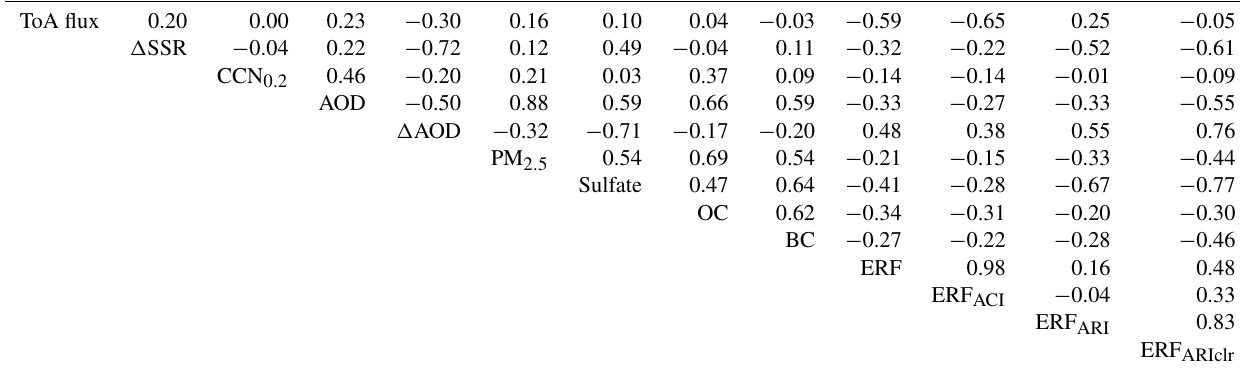
Table 3. Pearson linear correlations ( r ) between the PPE member regional mean model outputs for Europe in July, for the aerosol properties used as constraints and the 1850–2008 forcing variables, corresponding to the pairwise scatter plots in Fig. 2. ToA flux